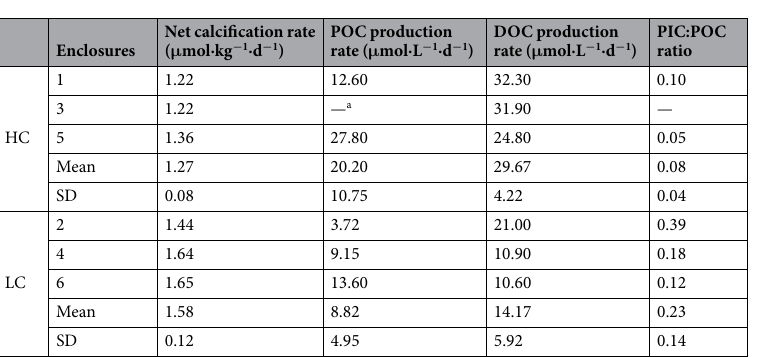
Table 1. The overall particulate inorganic carbon (PIC), particulate organic carbon (POC) and dissolved organic carbon (DOC) production rates and PIC:POC ratios during the mesocosm incubations for 15 days under present and elevated partial pressure of CO 2 ( p CO 2 = 400 and 1000 ppmv, respectively) in triplicate 4 m 3 enclosures. a POC samples were not collected in this enclosure during the